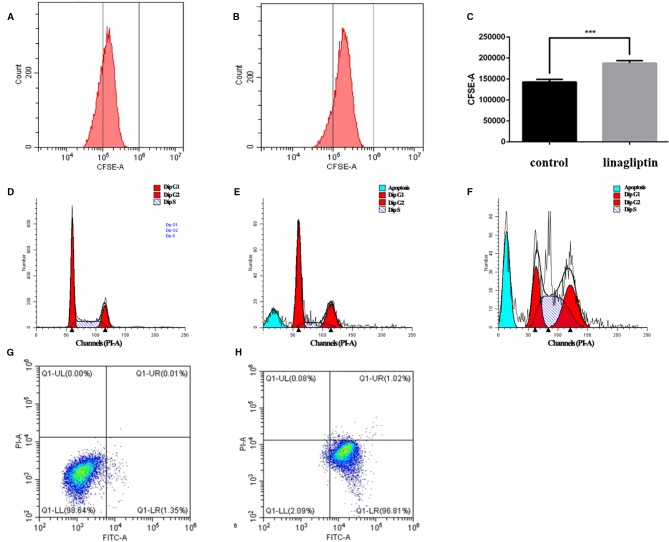
Linagliptin induces HCT 116 cell cycle arrest and apoptosis (A): Control fluorescence intensity of CFSE; (B): Fluorescence intensity of CFSE in linagliptin treated group (HCT 116 cells were treated with 100 μM linagliptin for 24 h); (C): Statistical difference between control group and linagliptin treated group in A; D–F: Cell cycle analysis by flow cytometry. (D): Cell cycle of control group; (E): 50 μM linagliptin induced cell cycle arrest at 48 h; (F): 100 μM linagliptin induced cell cycle arrest at 48 h; (G, H): Apoptosis analysis by flow cytometry. (G): Control group; (H): 100 μM linagliptin induced HCT 116 cell apoptosis at 48 h.